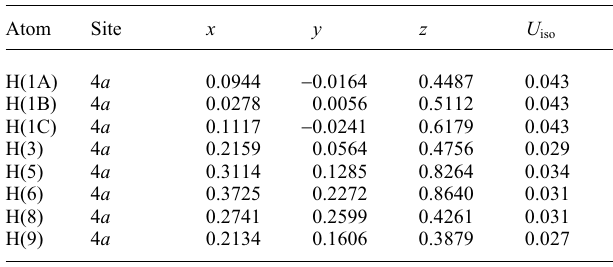
Table 3. Atomic coordinates and displacement parameters (in Å 2 )